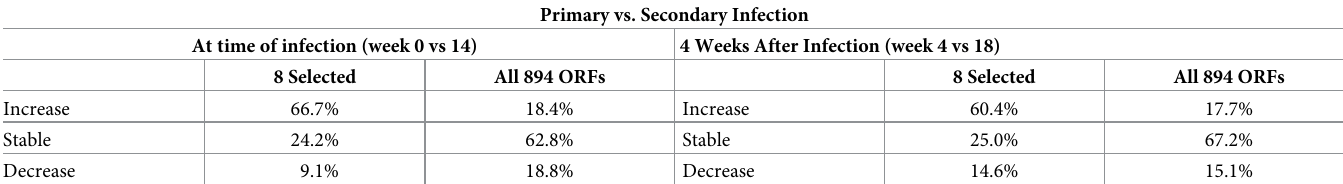
Table 3. Percentages of signals that increase or decrease between corresponding weeks of primary infection and secondary infection.